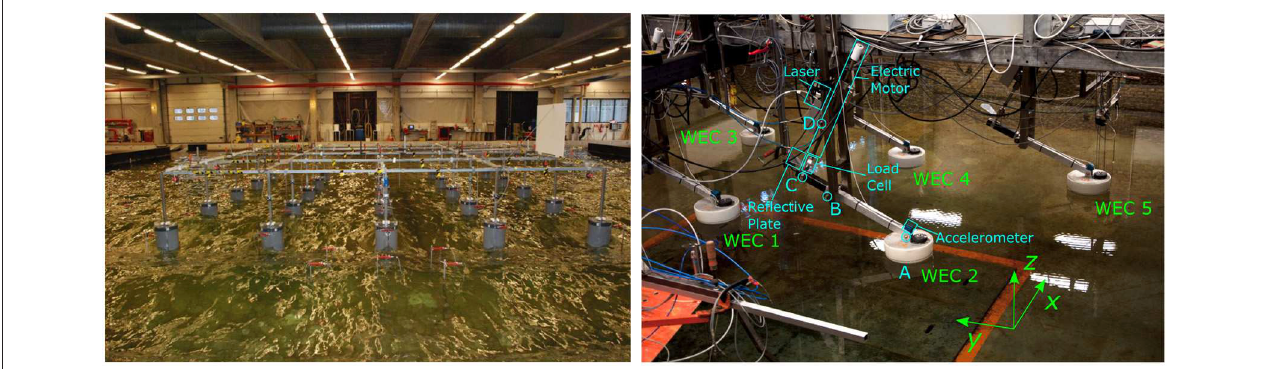
FIGURE 2 | (Left) Wave tank experiments with a park of 25 heaving buoys in irregular waves conducted at the DHI Shallow Water Basin, Denmark (Stratigaki et al., 2014). (Right) Experimental setup of five WaveStar models connected to linear control PTO systems (Mercadé Ruiz et al., 2017).